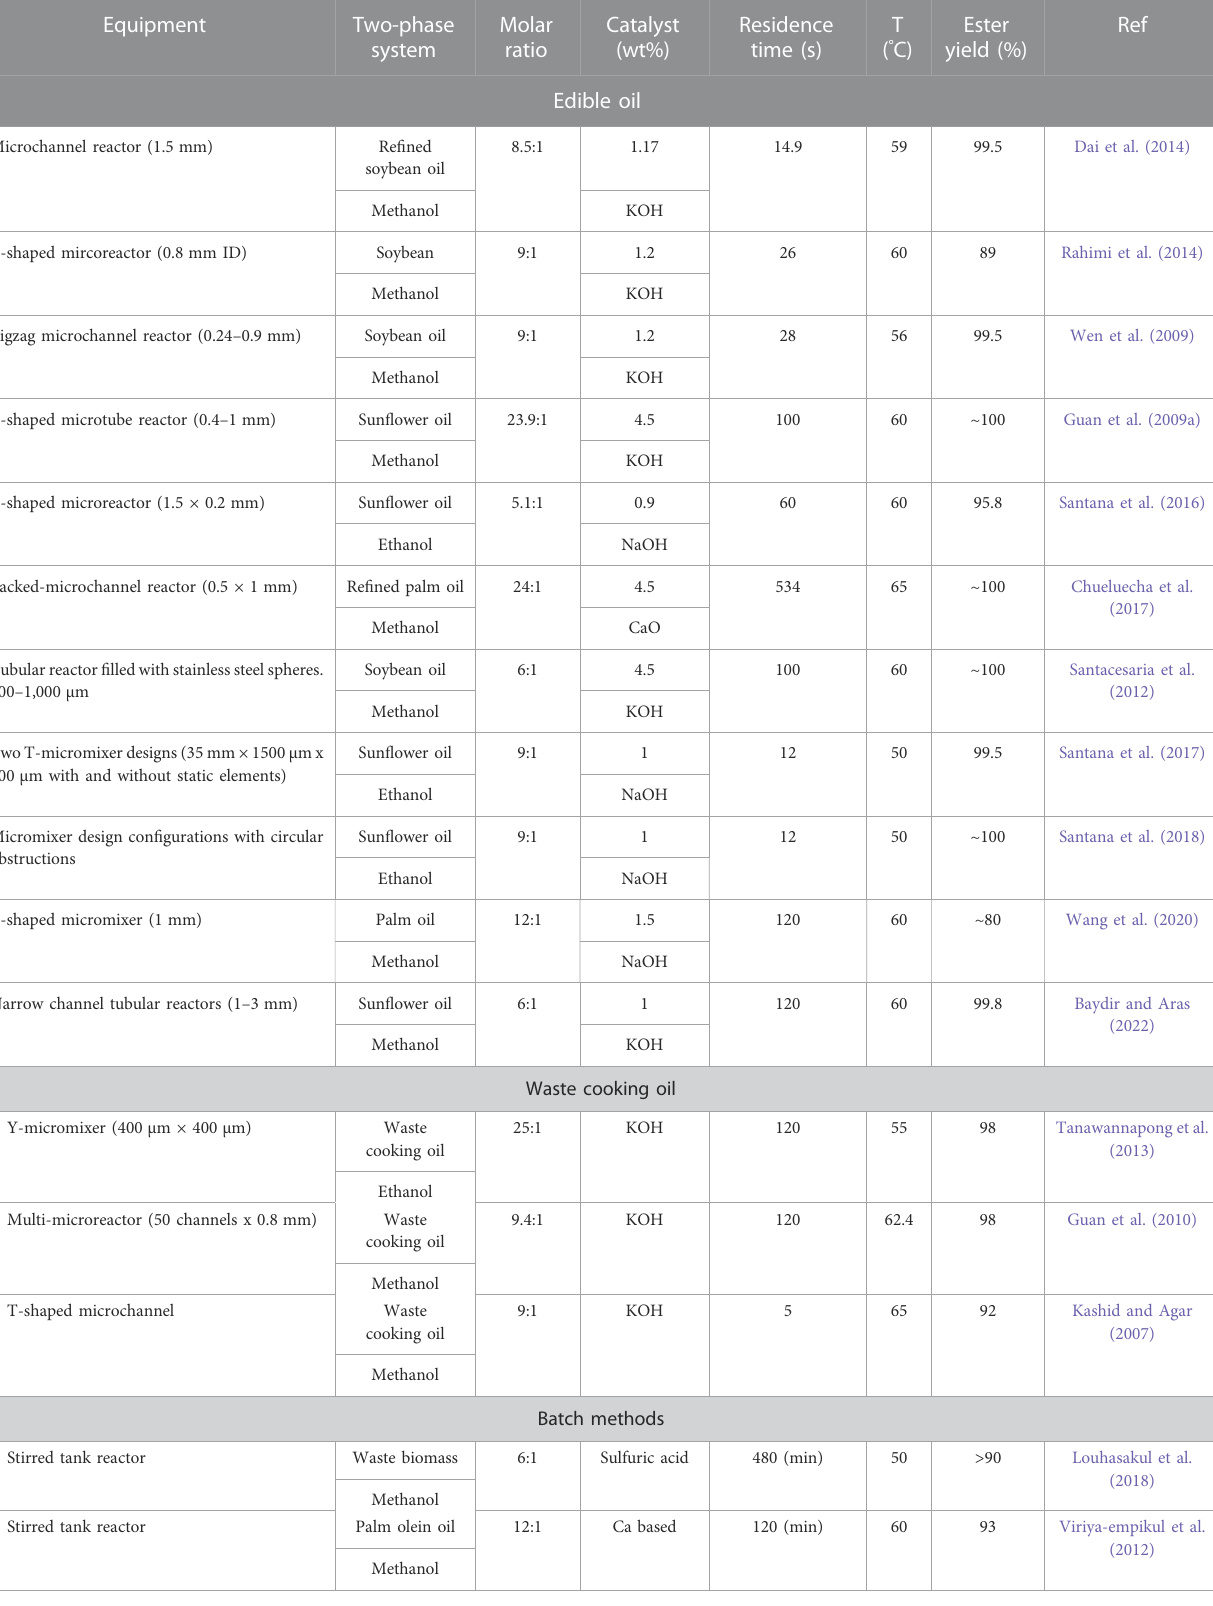
TABLE 1 Continuous biodiesel production from vegetable and waste cooking oil using micro-reactors and conventional